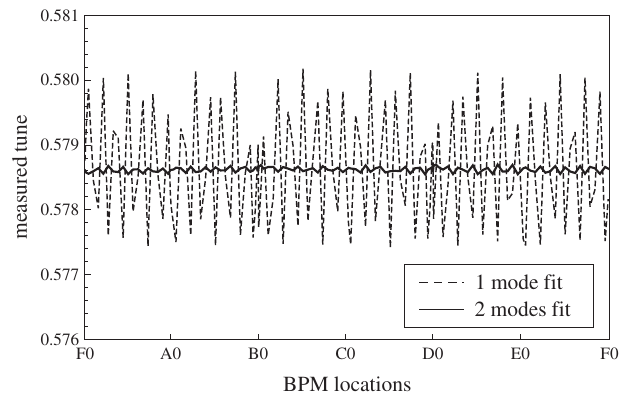
FIG. 8. The machine tune derived from the fit of the amplitude response at each BPM location. Inclusion of the secondary driving term gives a much more consistent result for the machine tune (global the Tevatron. The dashed and solid curves represent the fits